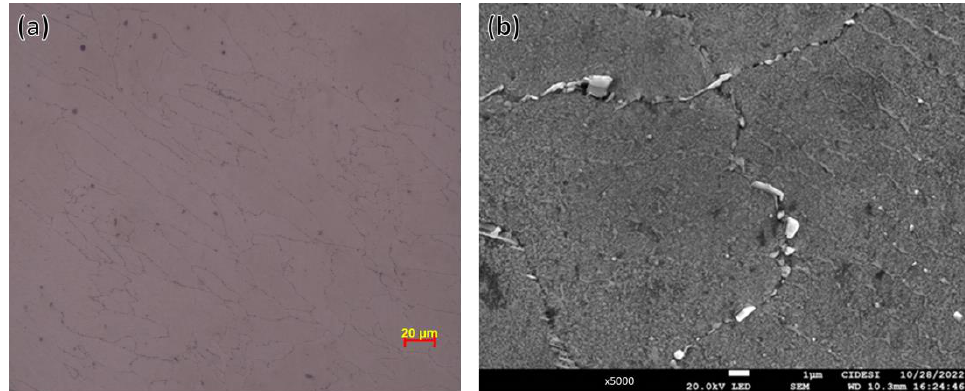
Figure 6. Microstructure of cellular IN718 after heat treatment with 10 h of aging. ( a ) Optical microscopy at 500 × . ( b ) SEM image at 5000 × .